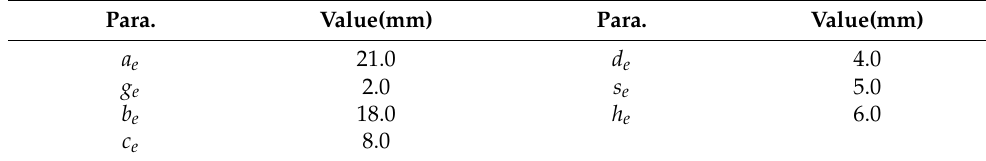
Table 2. Parameter dimensions of the SRR backed with strip line EBG. Para. Value(mm) Para.